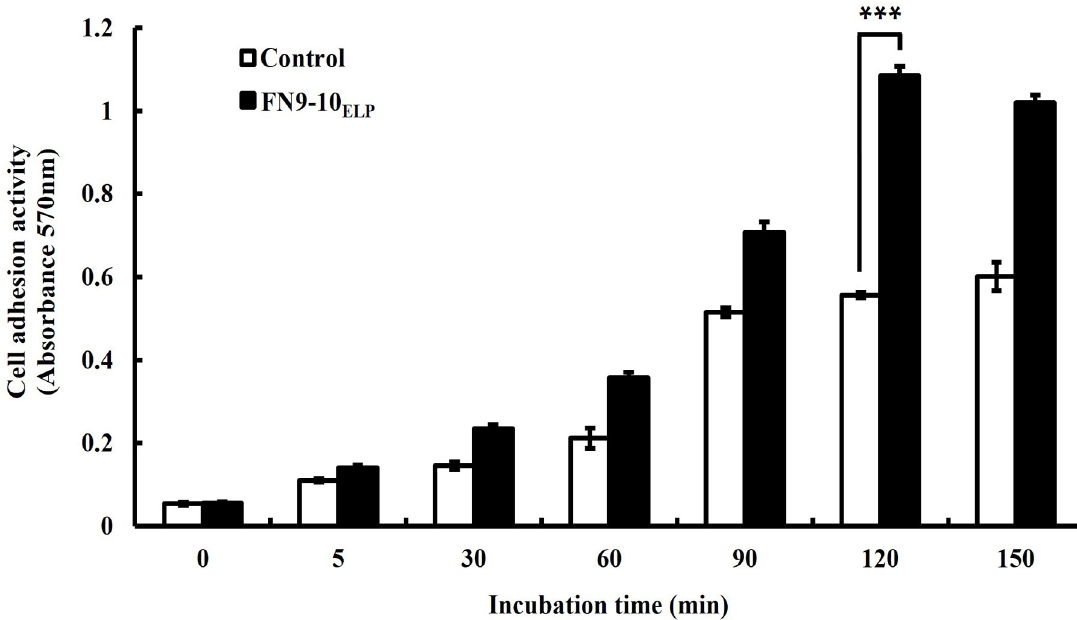
Fig 4. Cell adhesion activity of hMSCs according to incubation time on the FN9-10 ELP -titanium discs. The titanium discs were immersed overnight in 10 μ g � mL − 1 of FN9-10 ELP at 4˚C, and while the non-coated titanium discs served as the control. The hMSCs were seeded at a density of 1 × 10 5 cells/disc on the titanium discs and incubated at 37˚C for up to 150 min. The hMSCs adhesion activities were evaluated by crystal violet assay and are presented as the mean ± SD (n = 3). p < 0.001.